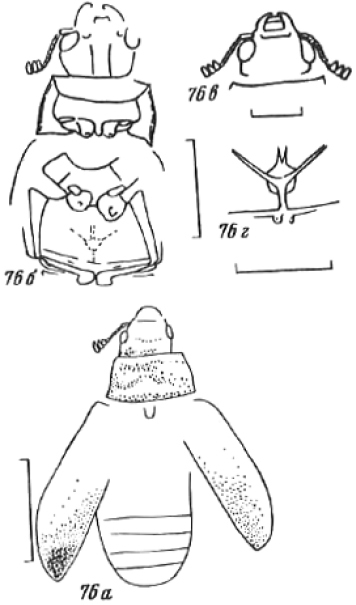
Cretocateres mongolicus Ponomarenko, 1986. A reproduction of the original table.